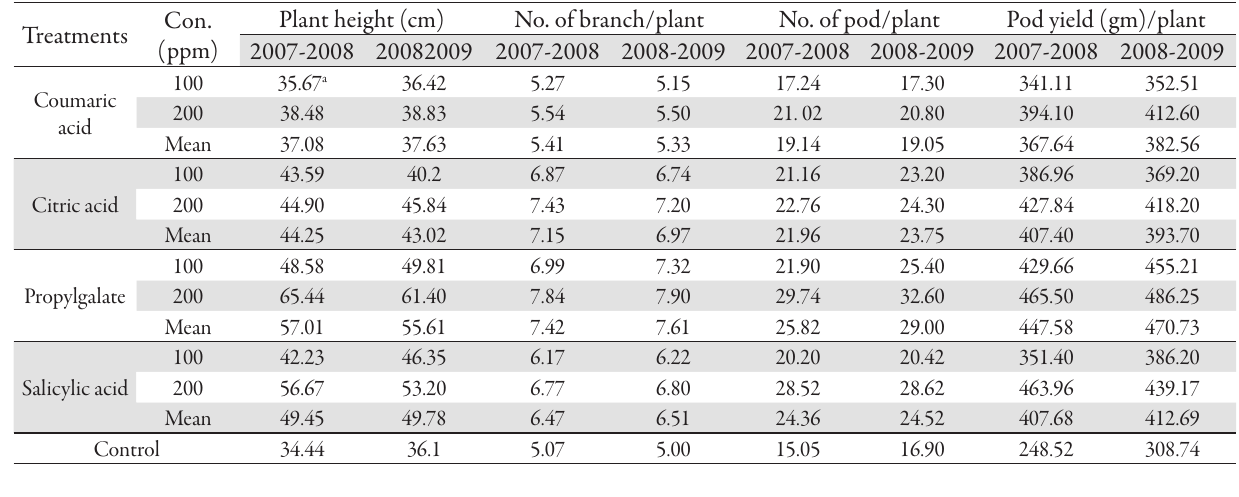
under field condition in season 2007-2008 and 2008-2009